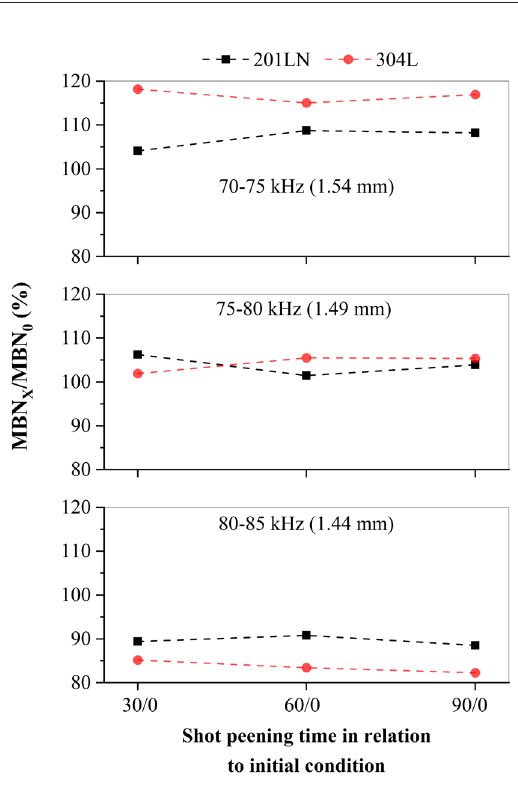
signals in relation to shot-peened MBN